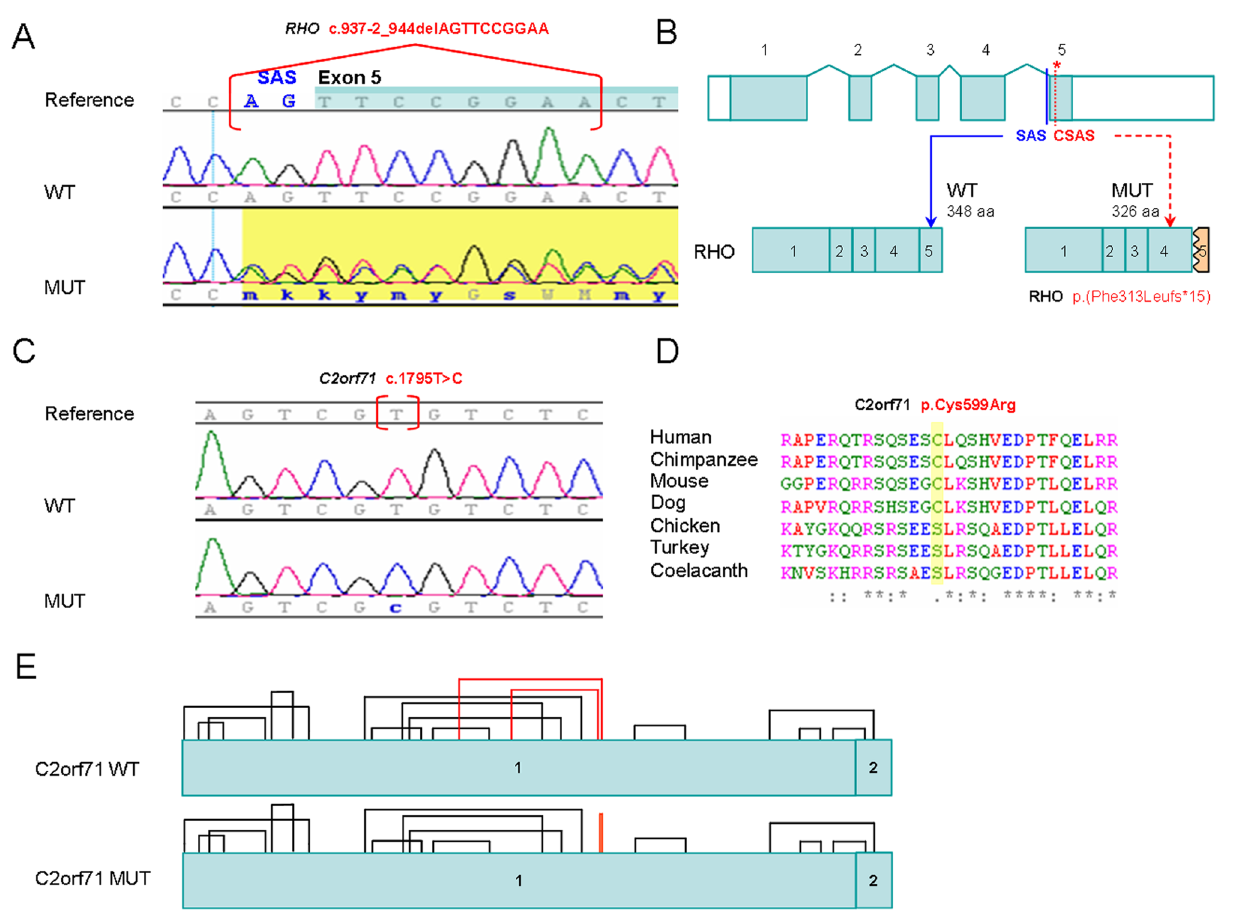
Fig. 2. Novel pathogenic variants identified in this study. A) Chromatograms of wild type (WT) RHO DNA sequence (NM_000539.3) and RP subject (MUT) showing the heterozygous mutation c.937-2_944delAGTTCCGGAA. SAS: Splice Acceptor Site. Exon 5 is highlighted in blue. B) The RHO gene structure is composed of 5 exons that are indicated as filled boxes while 5 9 and 3 9 UTRs are shown as open boxes. The canonical SAS of exon 5 is in blue and the predicted cryptic SAS (CSAS) is in red and indicated with an asterisk. The WT protein product (left) has 348 aminoacids (aa) while the predicted mutant product (MUT) only 326 aa. C) Chromatograms of WT C2orf71 (NM_001029883.2) DNA sequence and RP subject (MUT) showing the homozygous mutation c.1795T . C. D) Alignment of C2orf71 orthologous protein sequences showing conservation of the mutated residue p.Cys599Arg among mammals. E) Prediction of disulfide bonds formation for WTand mutant (MUT) C2orf71 proteins. According to the prediction, in the mutant protein structure, two of the disulfide bonds have been disrupted while a new one has been created. The disulfide bonds altered are in